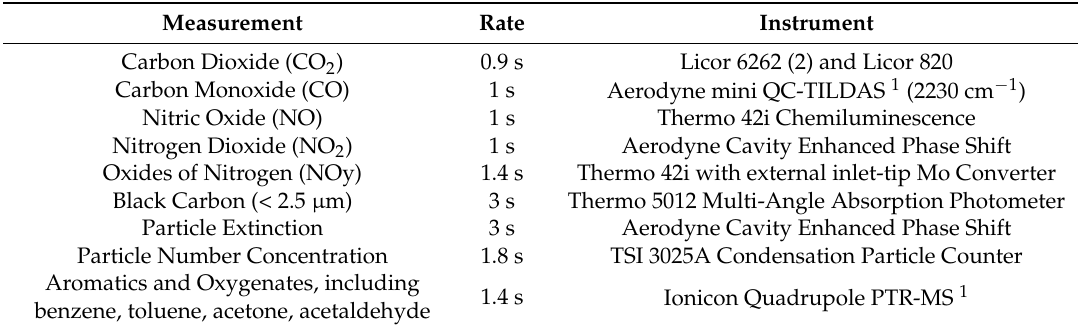
Table 1. Mobile monitoring instrumentation and sampling rates.